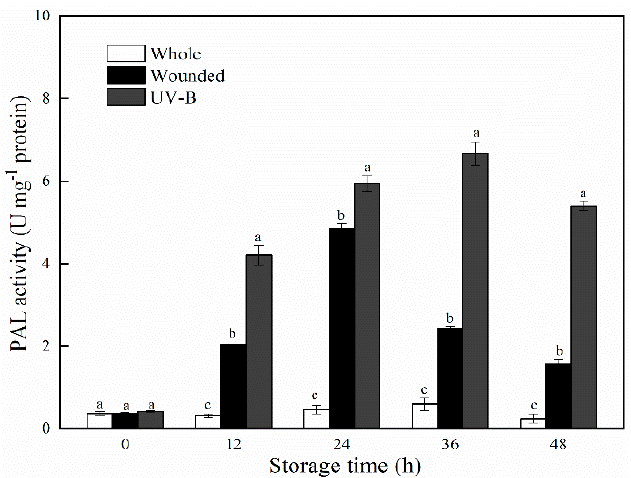
Figure 2. PAL activities of whole, wounded and UV-B–treated carrots stored at 15 ◦ C for 48 h. Data were expressed as the mean ± standard deviations of triplicate values. Lowercase letters represent significant difference ( p < 0.05) among treatment factors at the same sampling time.